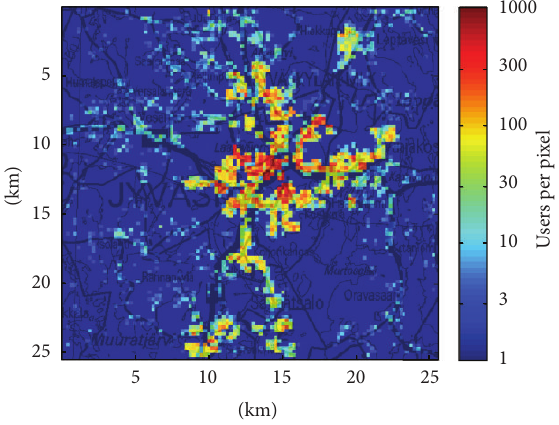
Figure 2: Secondary UE density map in the study